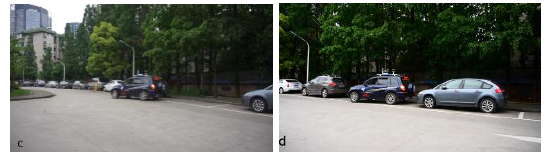
Figure 11. The processing of parallel parking